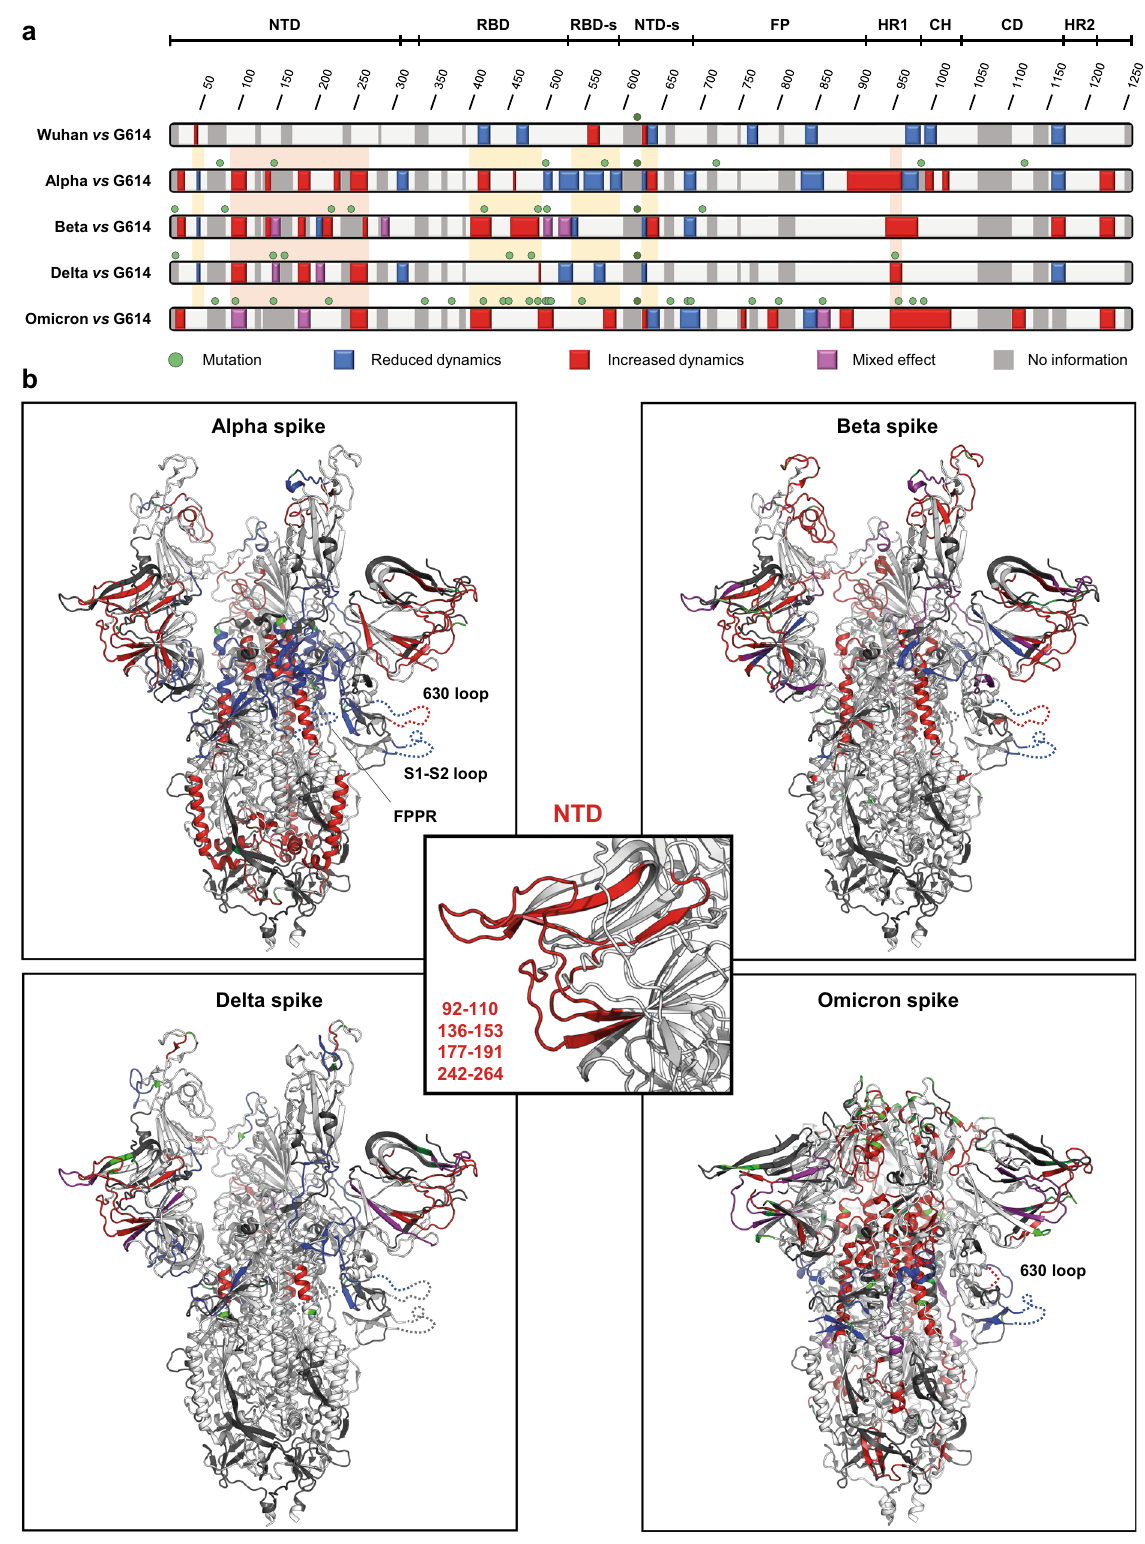
Fig. 2 | Conformational evolution of spike. a Map of HDX effects. Regions of various spike trimers with a signi fi cant difference in HDX compared to G614 spike are coloured along the spike sequence. In red: increased HDX; in blue: decreased HDX;inmagenta:mixed effect;inlightgrey:no differencein HDX;indarkgrey: no information; green spheres: sites of amino acid changes. Yellow rectangles frames regions reporting on a modulation ofclosed/openstate. Orange rectanglesframes regions ofHDX effects in commonamong the various spike trimers. b HDX effects